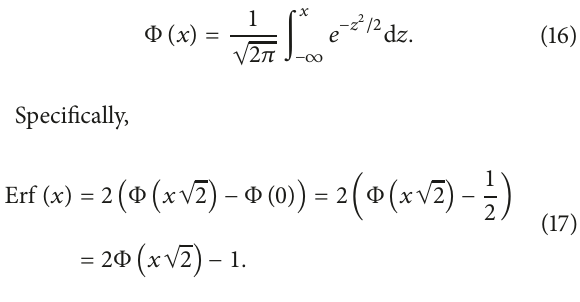
Figure 5: A simple explicit Euler scheme for the step size ℎ = 1/50 .